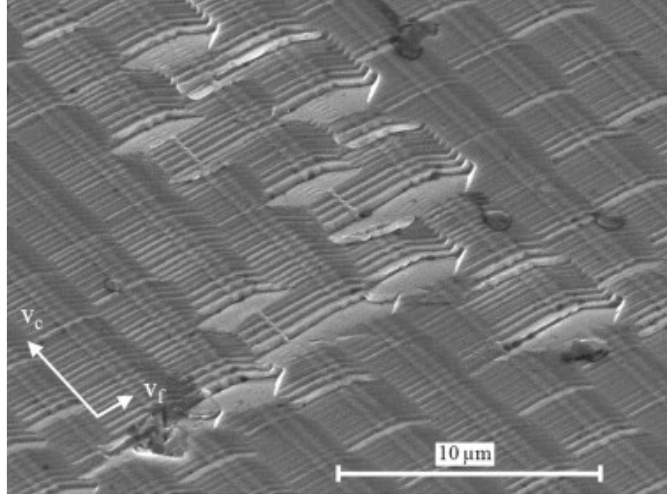
Figure 4. Scanning electron microscope (SEM) image of a diffractive surface generated by fast tool servo (FTS) in nickel silver. Reproduced with permission from [62].